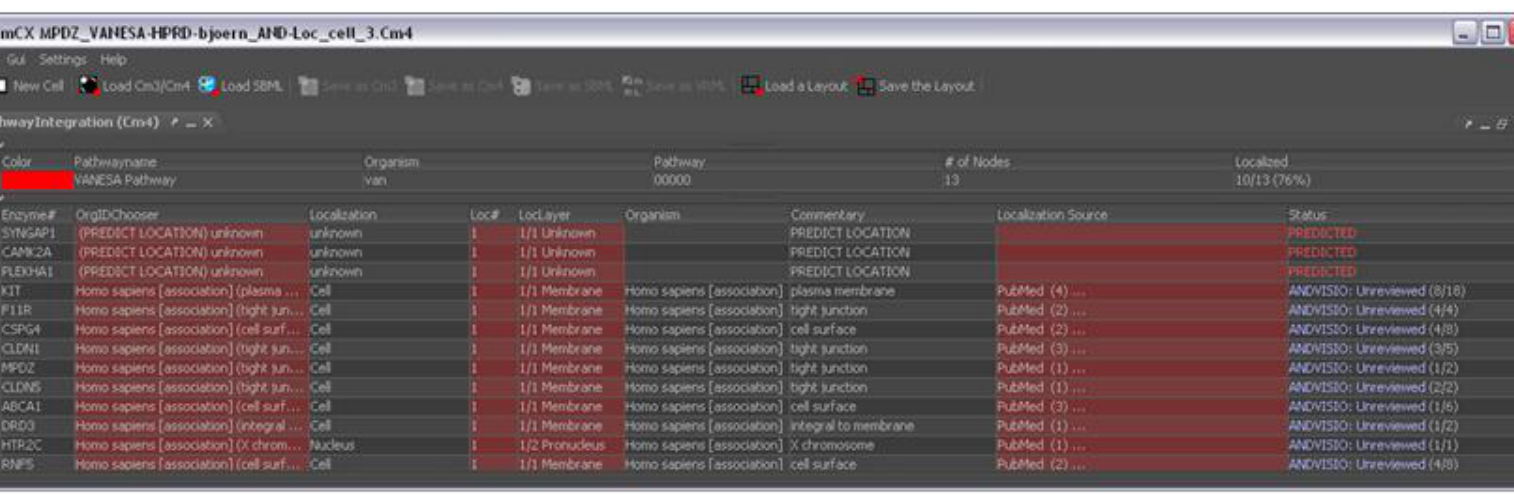
Figure 4: The localization of the MPDZ interacting protein network (Fig. 1) using CmPI: 5 proteins could be localized to the tight/cell junction (including MPDZ), 5 proteins to the cell membrane, 2 protein to membrane and 1 protein to the cytoplasm (SYNGAP1).